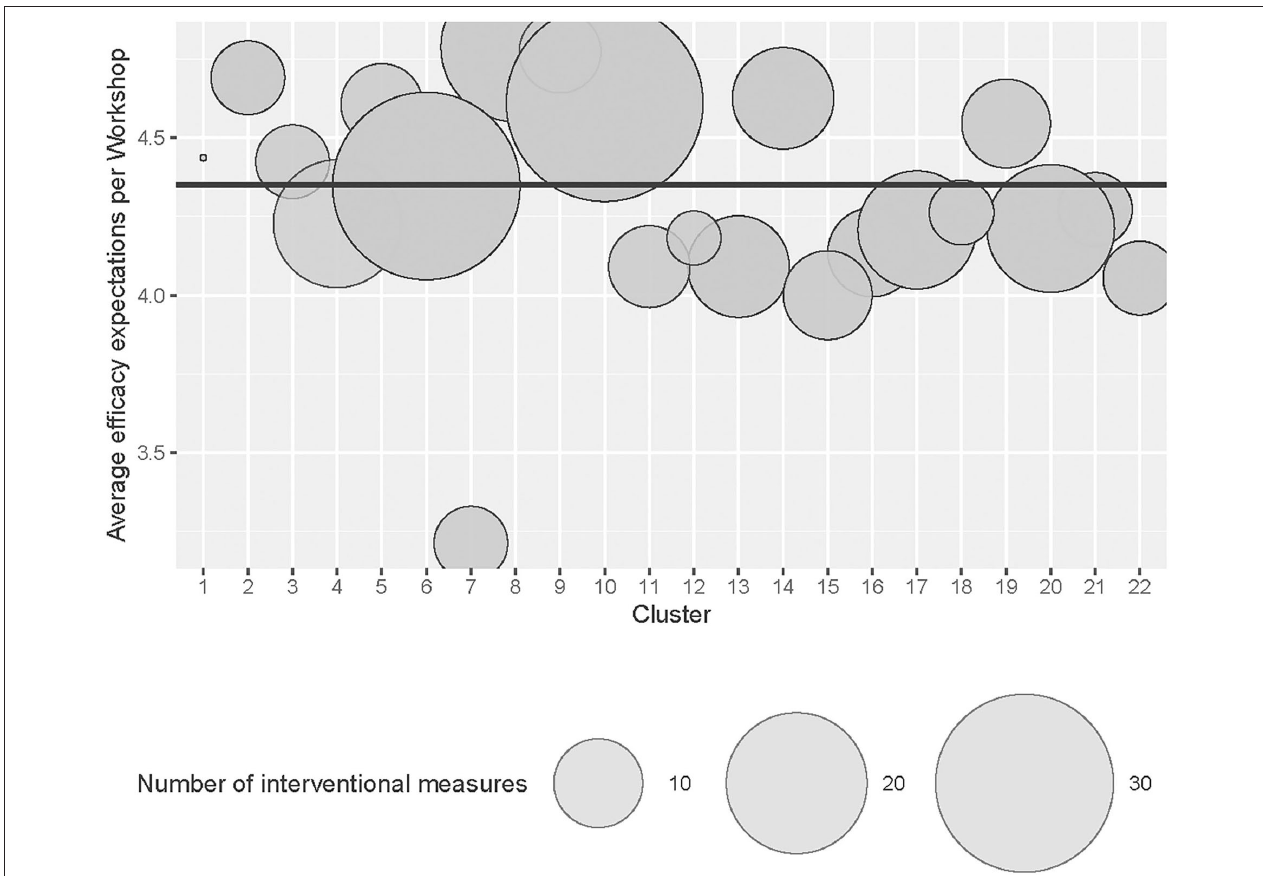
FIGURE 2 | Number of interventional measures across workshop groups